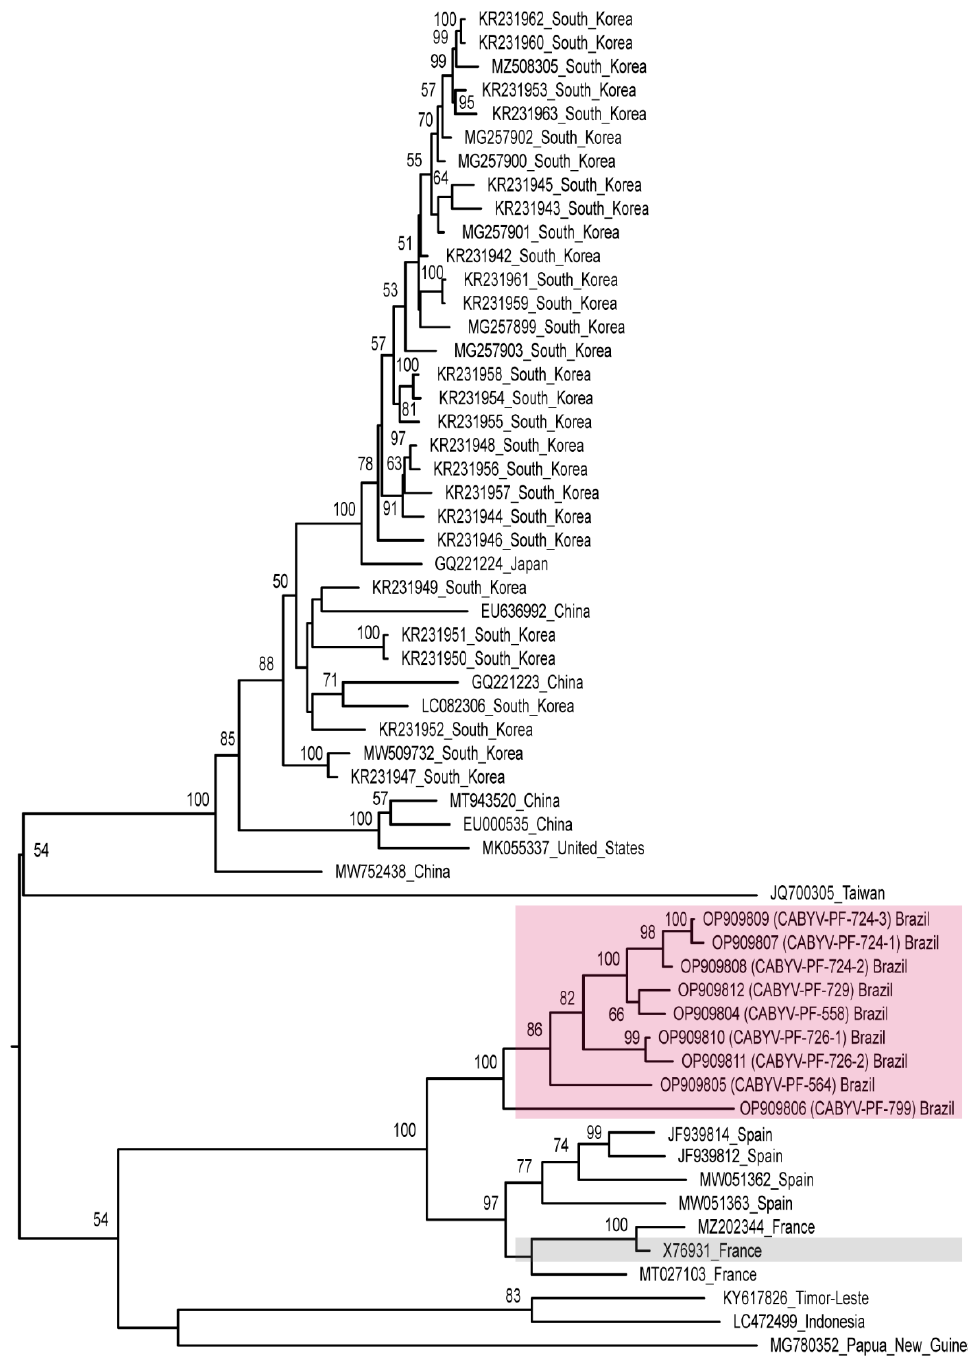
Figure 4. Midpoint-rooted phylogenetic tree of the complete genome sequences of CABYV sequences excluding CABYV recombinant sequences. Pink and gray boxes highlight CABYV-PF isolates and CABYV reference sequence, respectively. Phylogenetic trees were reconstructed using maximum likelihood in RAxML-NG v. 1.0.3 software using the MUSCLE alignment generated in Geneious Prime ® 2022.1.1. Bootstrap support values >50% for 1000 replicates are displayed on or near the branches. The bar indicates 0.02 nucleotide substitutions per site.